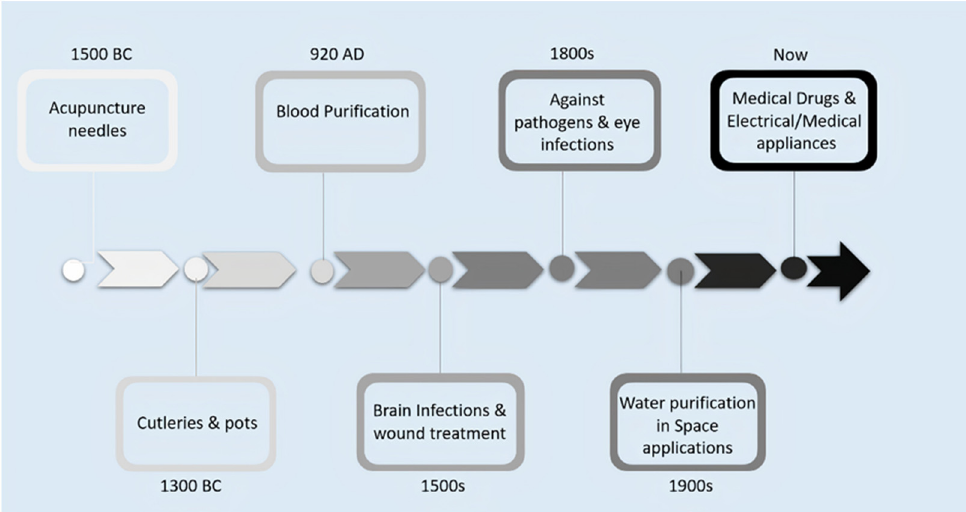
Figure 1. Timeline of various applications of silver (Ag).